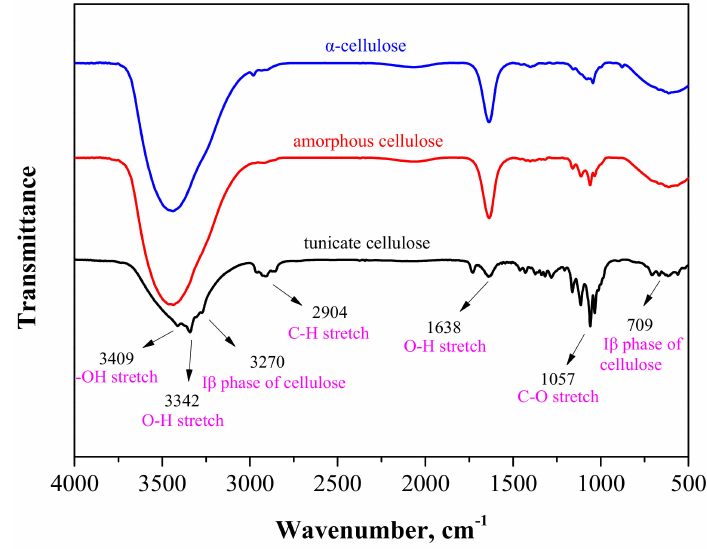
Figure 5. FTIR spectra of tunicate, pulp α and amorphous